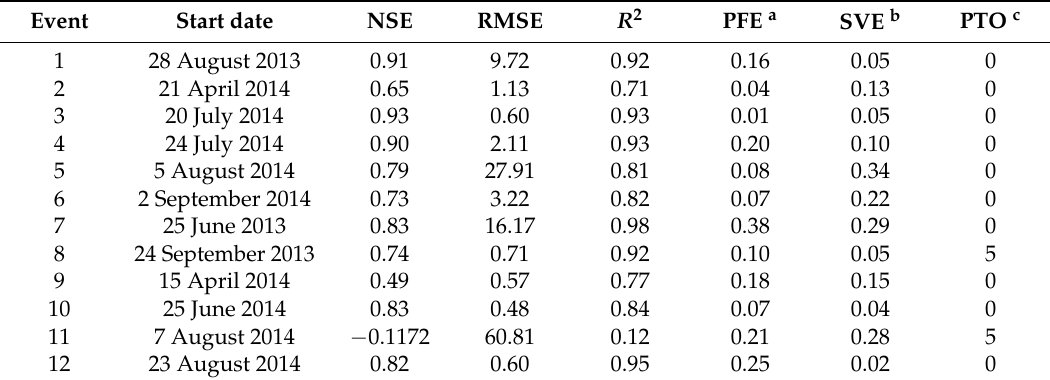
Table 5. Summary of calibration and validation statistics for the event condition.